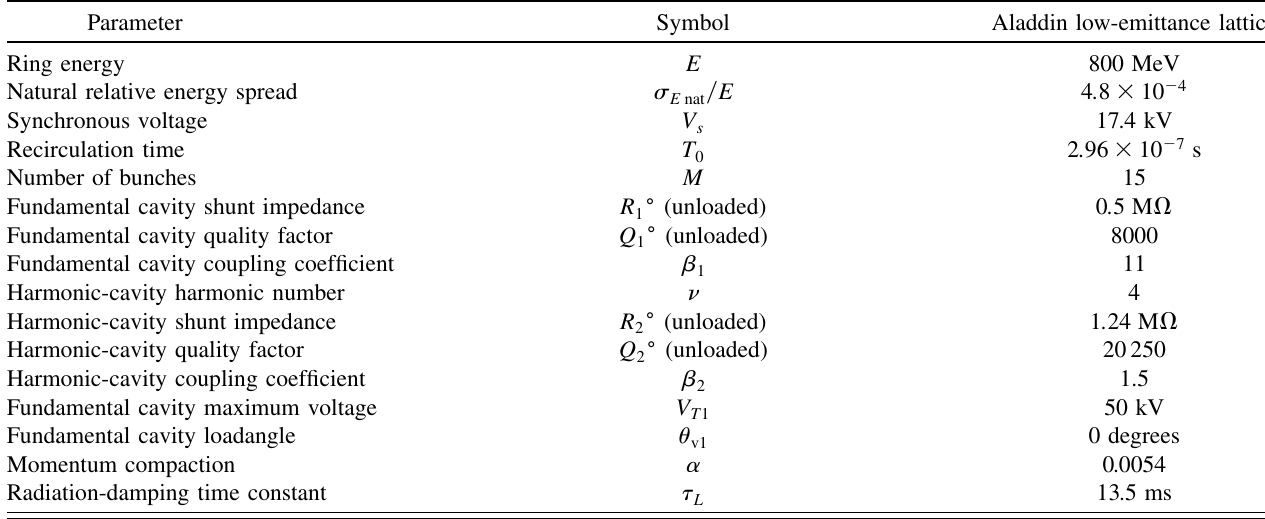
TABLE I. Parameters for the Aladdin low-emittance LF15 lattice. The shunt impedance value equals the resistance of the equivalent parallel RLC circuit, and is equal to one-half of the linac definition of shunt impedance.